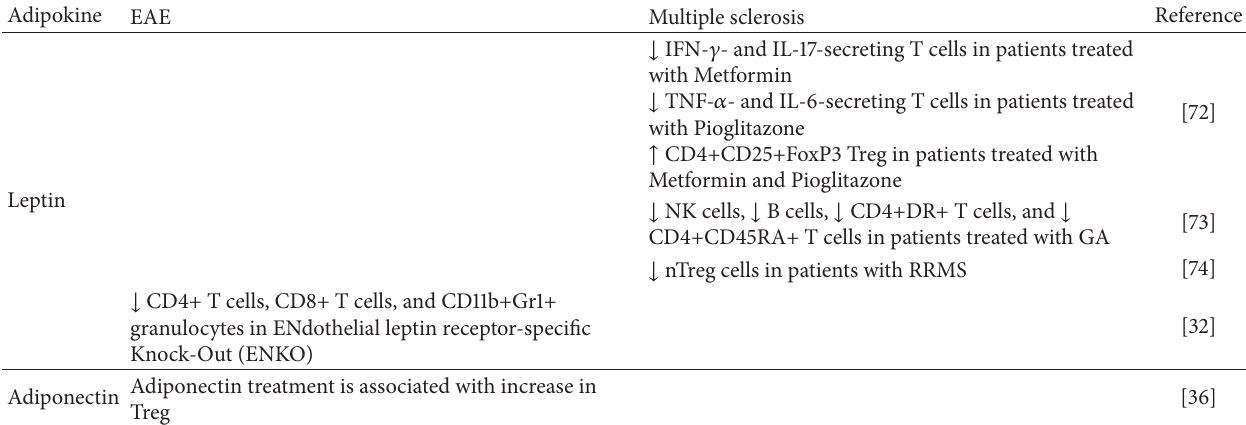
Table 1: Cell types affected in the experimental autoimmune encephalomyelitis (EAE) mouse model or in patients with multiple sclerosis